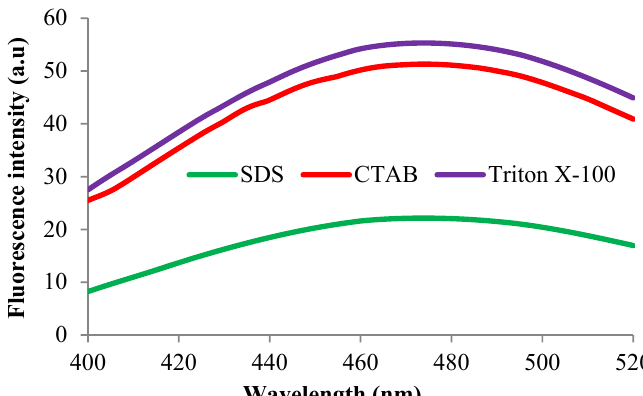
Fig. 4. Effect of surfactant type on the fluorescence intensity of ZEN. Conditions: dispersing solvent, 3 mL of MeCN/ water (80:20 v/v); extraction solvent, 320 µL of 1-octanol; water volume, 15 mL, equilibration time, 60 s, adsorbent amount, 40 mg; adsorption time, 3 min; desorption time, 4 min, desorption solvent volume and type, 1 mL of MeCN. Fig. 4